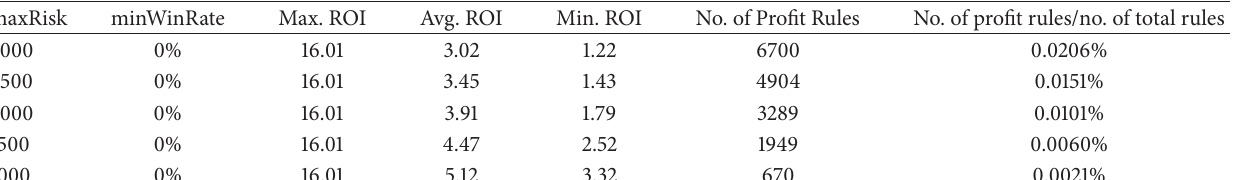
Table 8: Mining results of using various maxRisks.